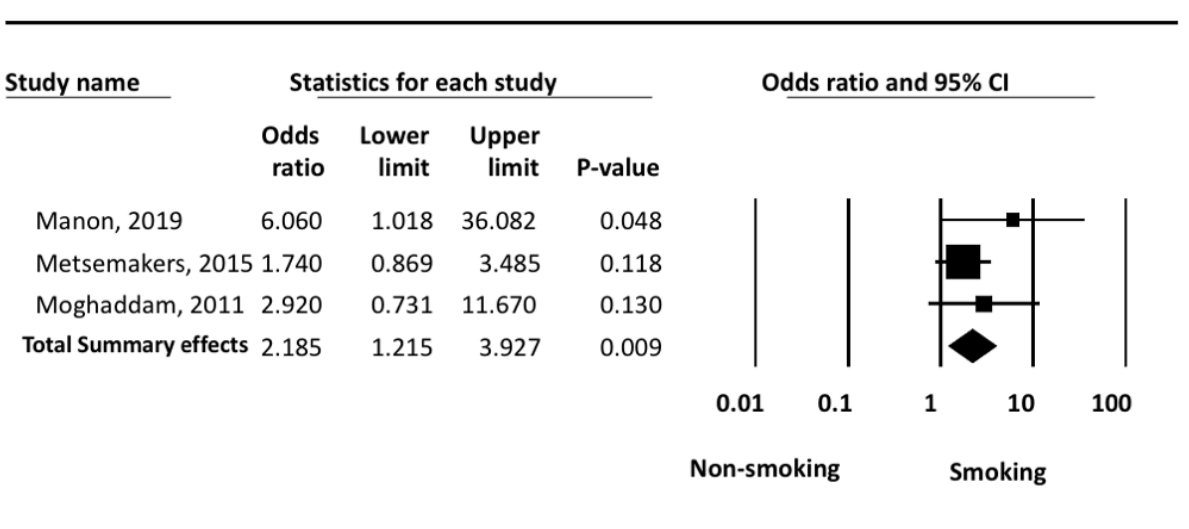
Figure 3. Meta Analysis of delayed union.